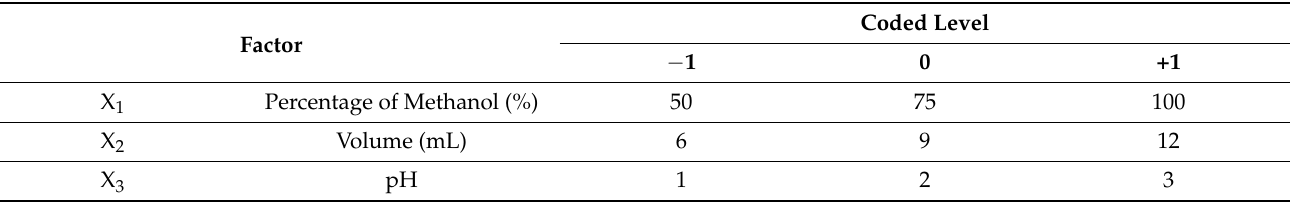
Table 4. Investigated variables and their levels studied in the Factorial and Doehlert designs for the optimization of elution of the phenolic